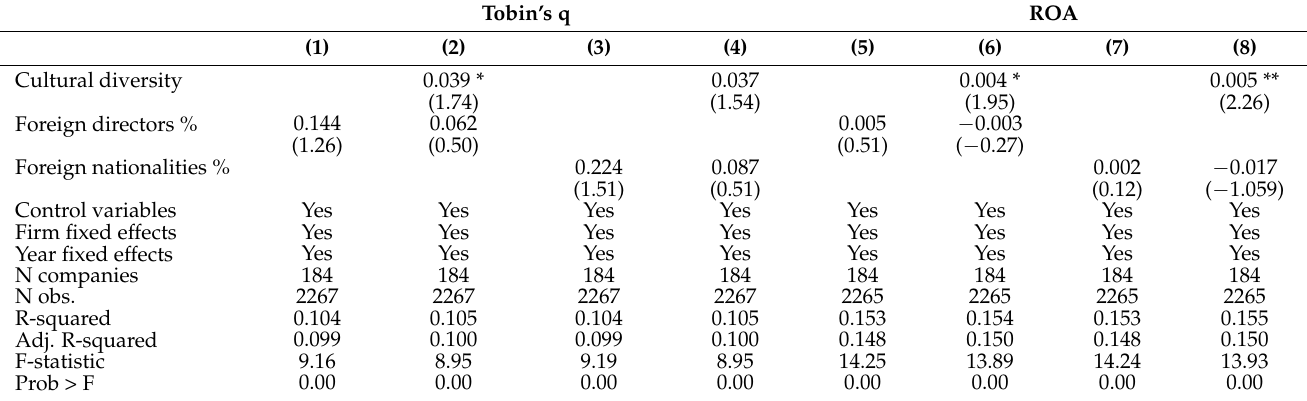
Table 5. Board cultural diversity vs. foreign directors on